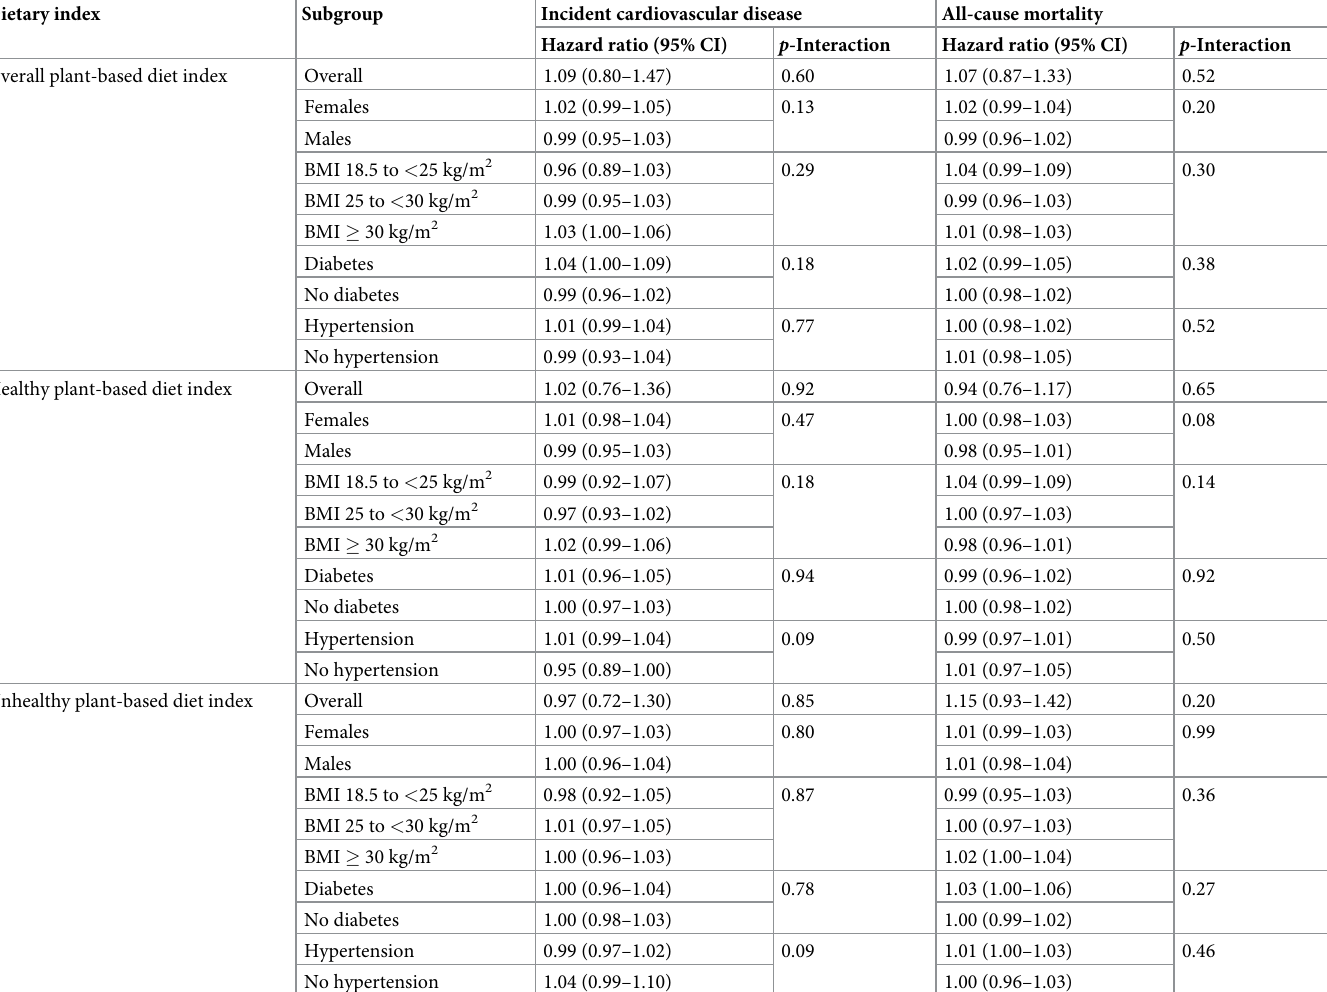
Table 4. Adjusted hazard ratios (95% CIs) for incident cardiovascular disease and all-cause mortality for highest versus lowest tertile of plant-based diet scores according to sex and baseline diabetes status, hypertension status, and body mass index (BMI). Dietary index